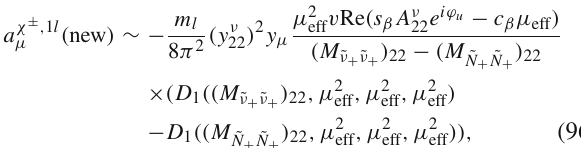
by the chargino one-loop contribution and strongly increases from0tomorethan350%intherangeofthe y ν vari- with y ν 22 22 ation. In the upper right plot of Fig. 2 we show the variation of the loop-corrected Higgs boson mass for the h u -like state ) as a function of y ν . As can be inferred at order O (α t α s + α 2 t 22 > 0 . 65 the neutrino/sneutrino from the plot, in the region y ν 22 sector strongly affects the mass of the h u -like Higgs